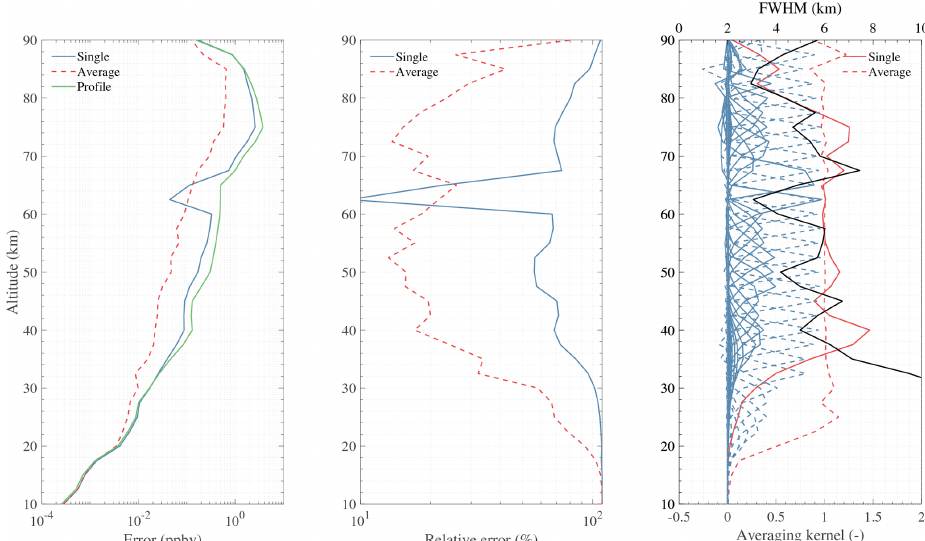
Figure 24. Simulation results of HO 2 retrieval using 649.701GHz lines. “Single” and “Average” represent the retrieval error using different noise. “Profile” represents the typical profile used in the simulation. The black solid line in the last panel represents the FWHM (i.e. vertical resolution).